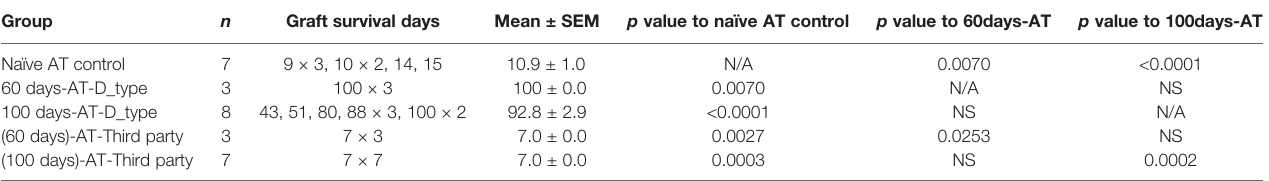
TABLE 2 | The detailed graft survival data after adoptive transfer of splenocytes. Group n Graft survival days Mean ± SEM p value to naïve AT control p value to 60days-AT p value to 100days-AT Naïve AT